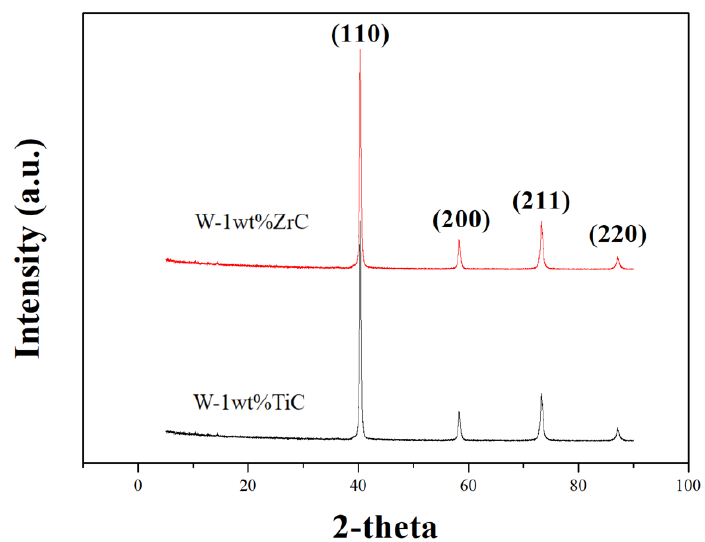
Figure 3. Phase identification for the SPS-sintered W-1wt%TiC and W-1wt%ZrC.